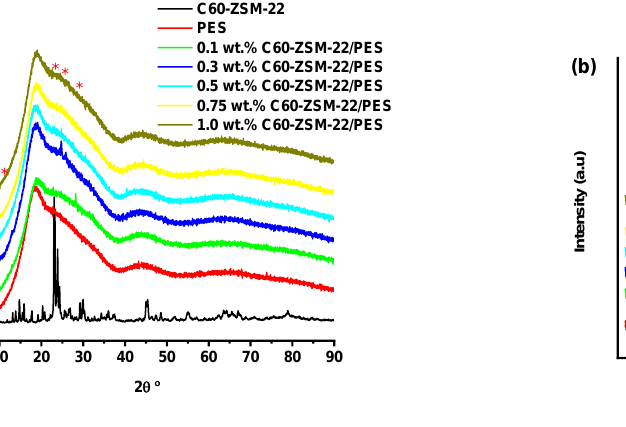
Figure 1. X-ray diffraction patterns of nanofiltration membranes prepared through a phase inversion method to a nominal wt.% loadings of 0, 0.1, 0.3, 0.5, 0.75, and 1.0 using ZSM-22: ( a ) C60-ZSM-22/PES and ( b ) F60-ZSM-22/PES with zeolite as